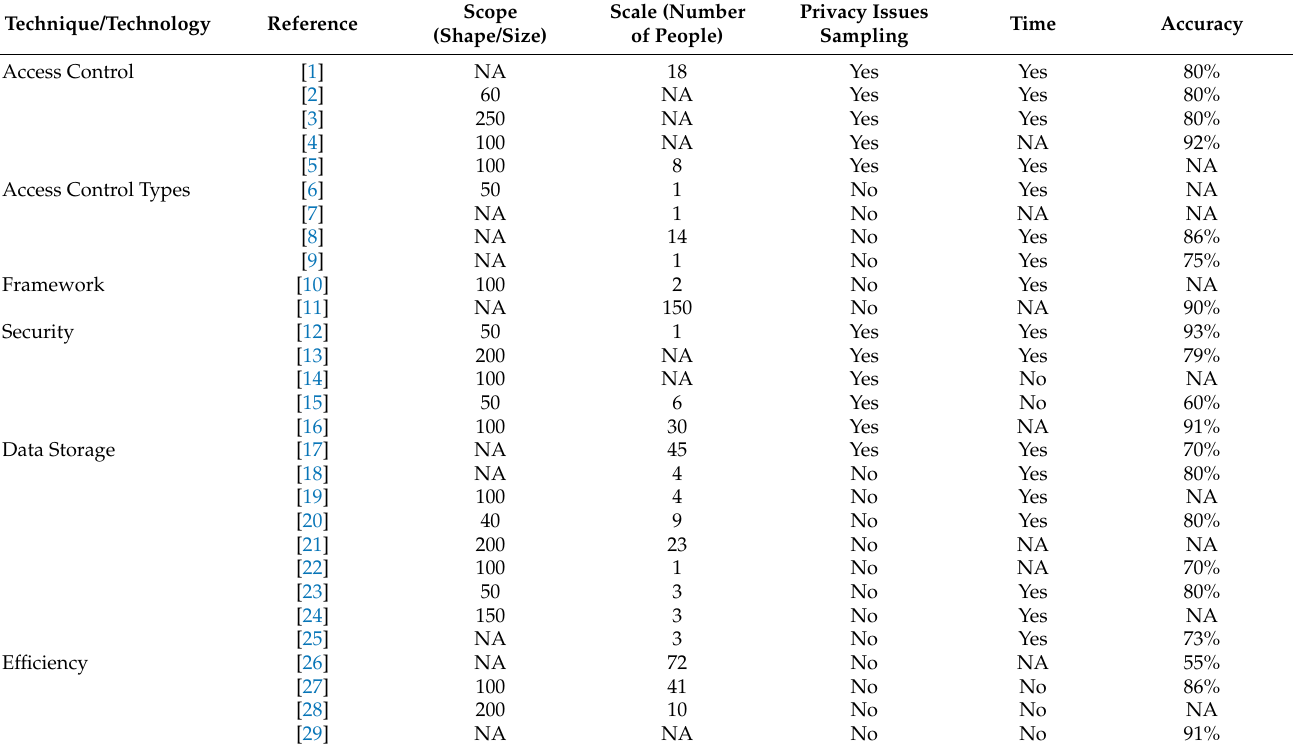
Table 1. Access control type, scope, scale, privacy issues, real time dataset used and the accuracy of various occupancy